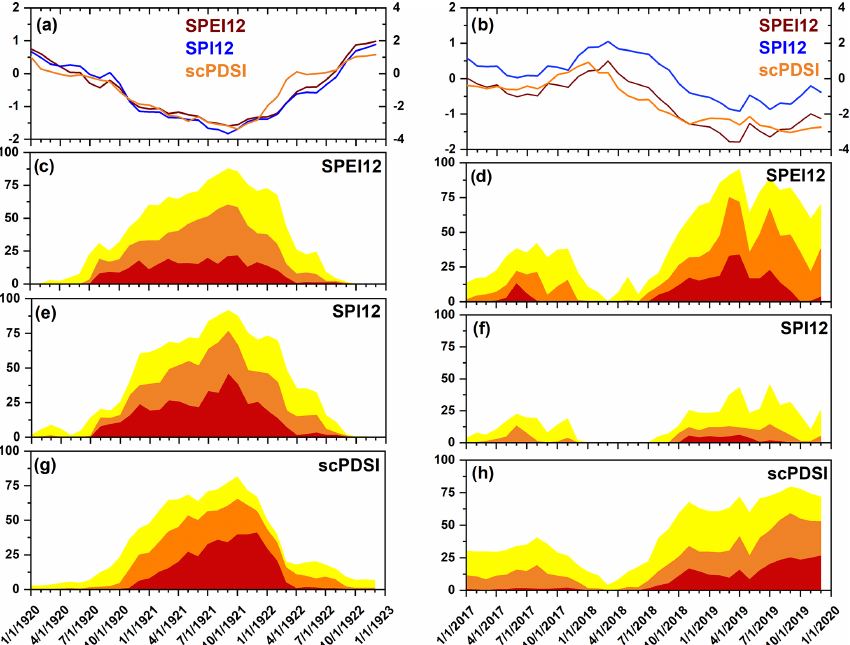
Figure 11. (a) Temporal evolution of the monthly SPEI12 (red line), SPI12 (blue line), and scPDSI (orange line) for the period January 1920– December 1922. (b) As in (a) , but for the period January 2017–December 2019. (c) Temporal evolution of the drought area for the SPEI12 for the period January 1920–December 1922 for different types of drought: moderate (yellow), severe (orange), and extreme (red). (d) As in (b) , but for the period January 2017–December 2019. (e) Temporal evolution of the drought area for SPI12 for the period January 1920– December 1922 for different types of drought: moderate (yellow), severe (orange), and extreme (red). (f) As in (e) , but for the period January 2017–December 2019. (g) Temporal evolution of the drought area for the scPDSI for the period January 1920–December 1922 for different types of drought: moderate (yellow), severe (orange), and extreme (red). (h) As in (g) , but for the period January 2017– December